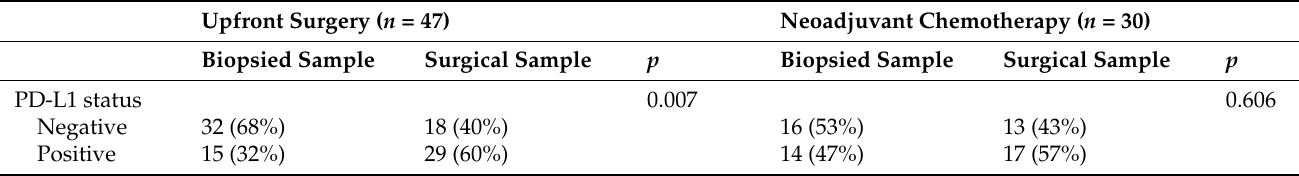
Table 1. PD-L1 status and means of percentage score between multiple samples in each